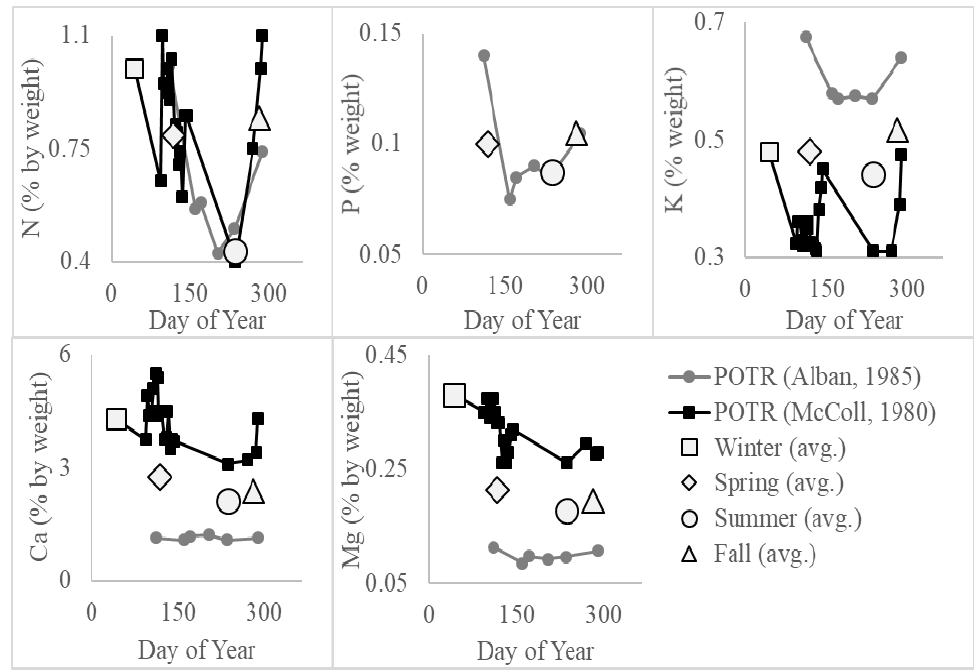
Figure A4. Seasonal twig macro-nutrient concentrations by day of the year observed in aspen, as well as the average of the seasonal averages across studies (Derived from [13,46–49]). The macro-nutrients all show increases during the dormant season while decreasing during the growing season. Trembling aspen ( Populus tremuloides ) is represented by POTR, and bigtooth aspen ( Populus grandidentata ) is represented by